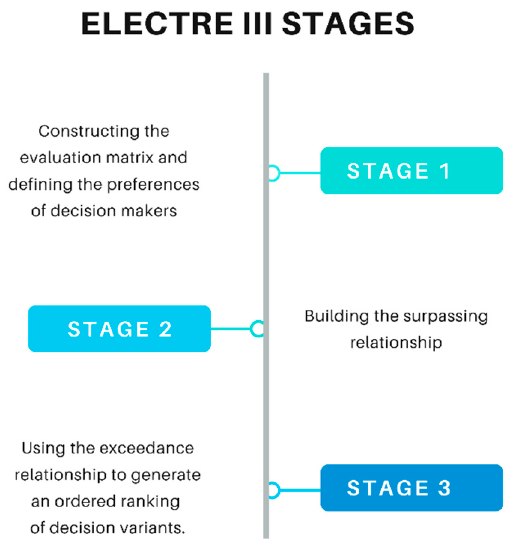
Figure 2. ELECTRE III method process.